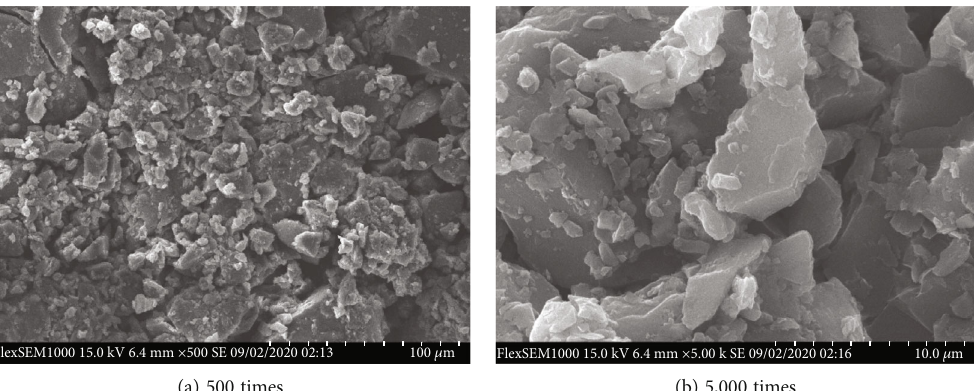
Figure 5: Particle attachment of coal sample under di ff erent magni fi